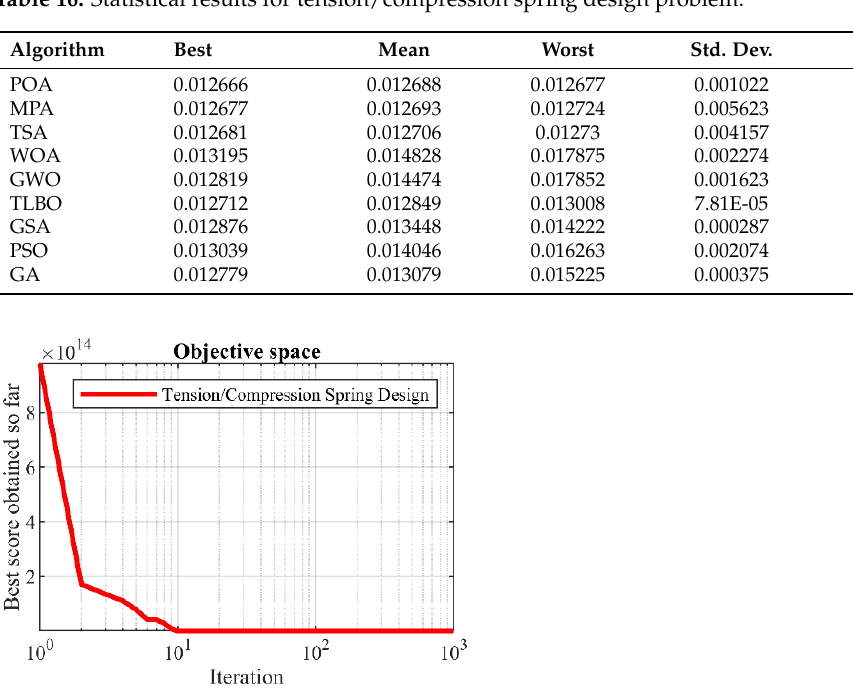
Table 16. Statistical results for tension/compression spring design problem.